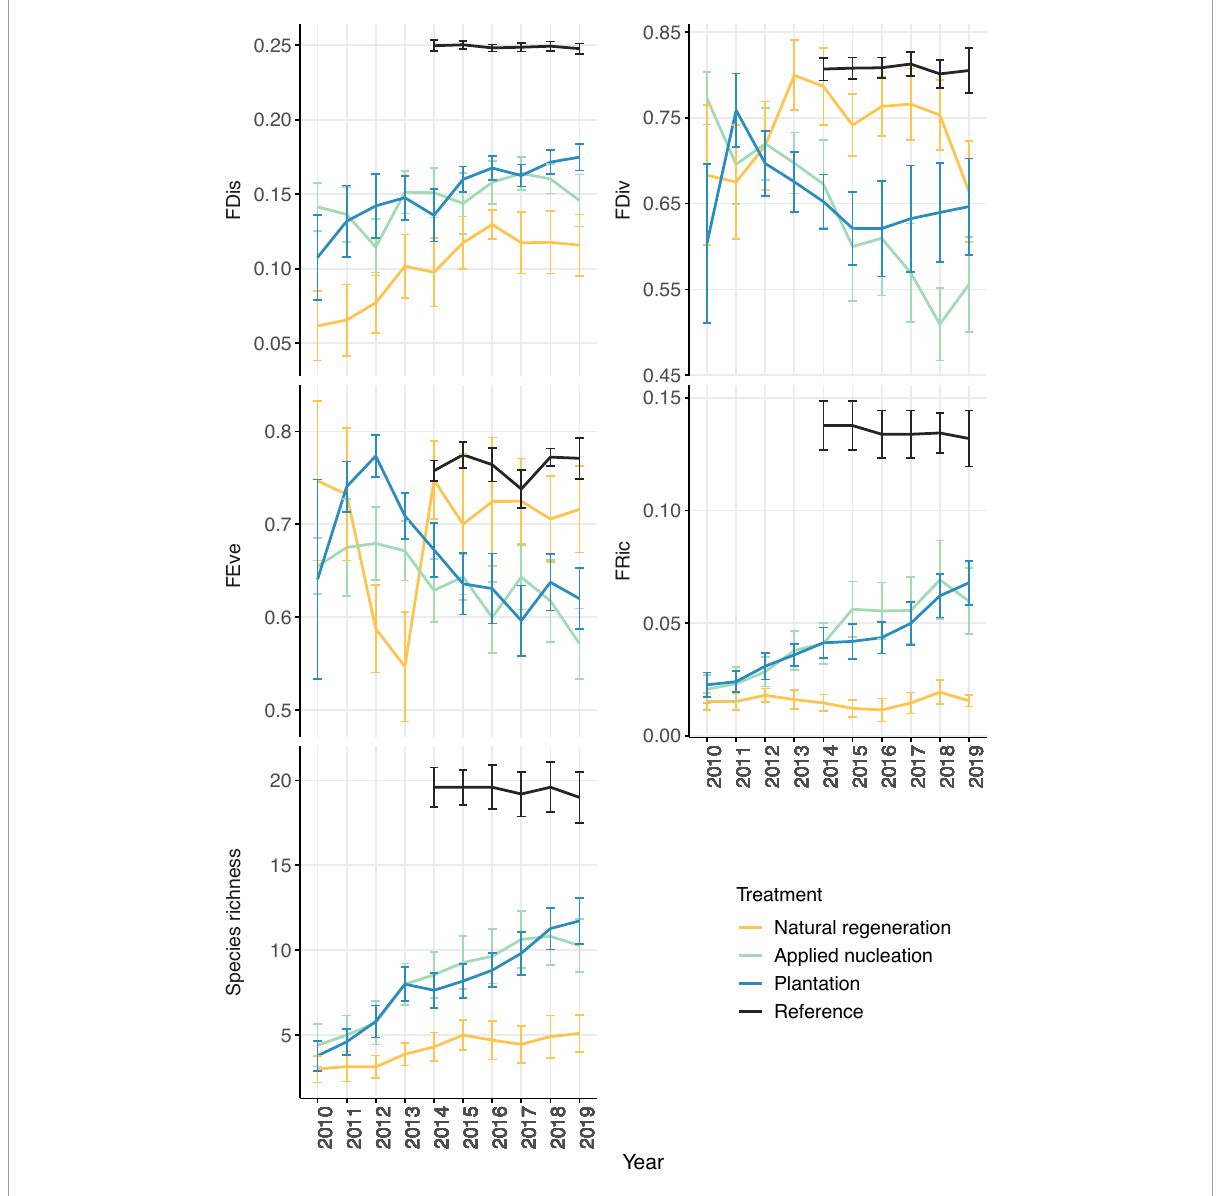
FIGURE2 Annual treatment-level means ( ± SE) of tree sapling functional richness (FRic), divergence (FDiv), dispersion (FDis), evenness (FEve), and mean species richness values from 2010 to 2019 (2014–2019 in reference forest) in each treatment. Sample size: n = 11 sites in natural regeneration, applied nucleation, plantation; n = 5 sites in reference.